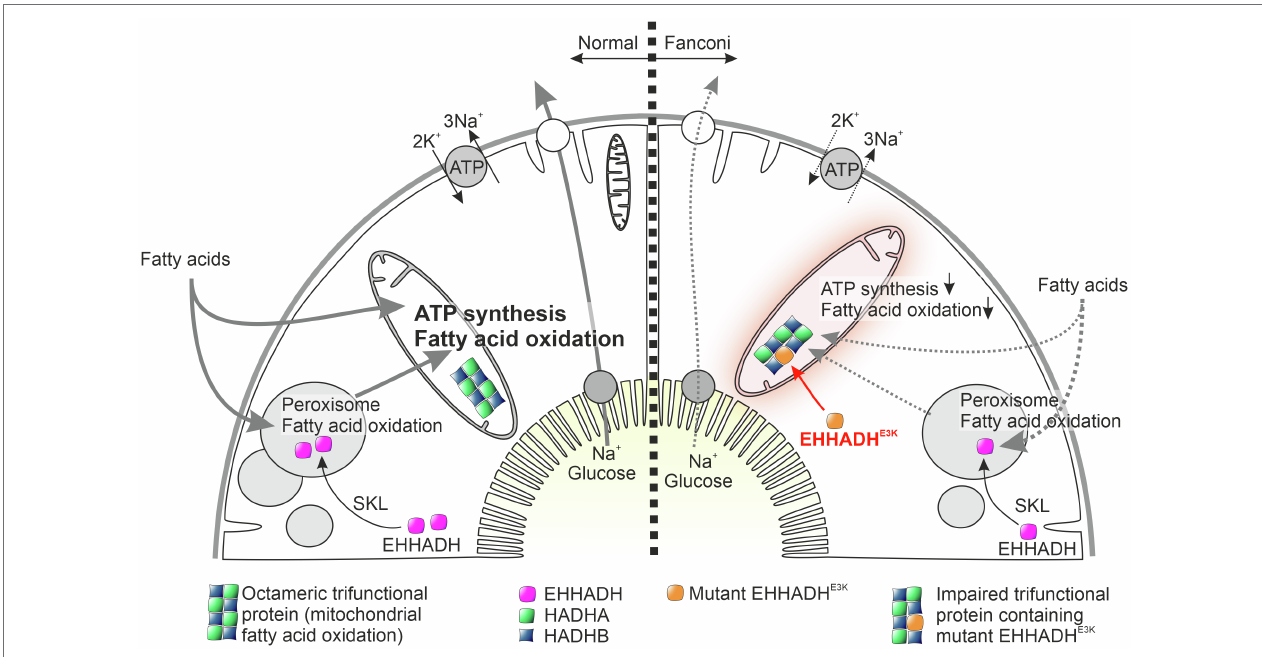
FIGURE 1 | Working hypothesis on the pathophysiology of mutant EHHADH-induced Fanconi’s syndrome without kidney failure. The physiological function of normal EHHADH is shown on the left, and the situation in cells carrying the EHHADH E3K mutation is shown on the right. Normally, EHHADH is imported into peroxisomes based on a C-terminal targeting sequence (SKL motif), where it plays a role in beta-oxidation of long fatty acids. The N-terminal missense mutation of EHHADH found in our patients generates a mitochondrial targeting signal that leads to pathological import of mutant EHHADH into mitochondria. In the mitochondrial matrix, mutant EHHADH presumably replaces HADHA within the octameric trifunctional protein, an enzyme complex required for mitochondrial fatty acid oxidation. Like a faulty component in a machine, mutant EHHADH thus interferes with mitochondrial fatty acid degradation and ATP synthesis. Proximal tubular cells, which normally transport large amounts of substrates and water under ATP consumption, are therefore no longer able to maintain their normal reabsorption capacity. As a result, glucose, amino acids, bicarbonate, and low molecular weight proteins are lost to the urine. Interestingly, proximal tubular cells do not appear to be further damaged by impaired mitochondrial fatty acid degradation and no damage-associated proinflammatory signals are